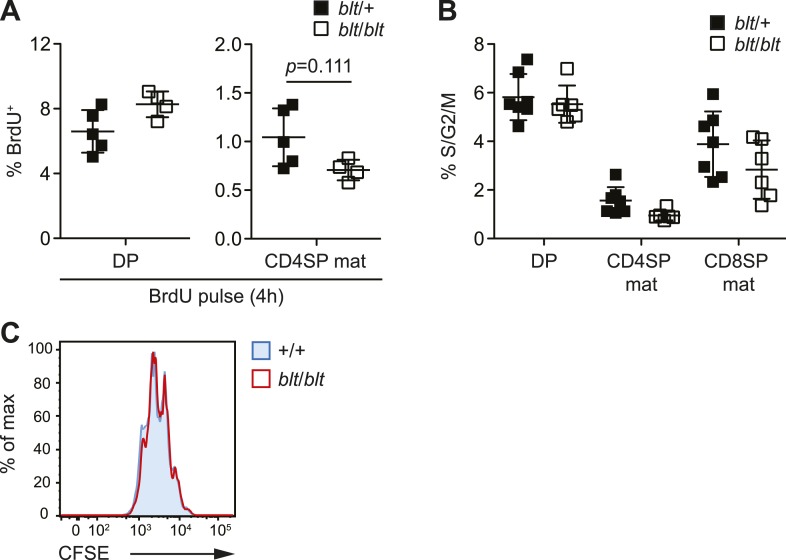
blt/blt naïve T cells proliferate normally in response to TCR
stimulation in vitro and show no significant reduction in cycling of
mature SP thymocytes.(A) BrdU labeling of DP and mature CD4SP thymocytes from
blt/+ (n = 5) and
blt/blt (n = 4)
mice after a 4 h pulse (mean ± s.d., two-tailed Mann-Whitney test).
(B) Percentage of indicated thymocyte subsets in S/G2/M
phases of the cell cycle, as defined by >2n DNA content. Data pooled
from three independent experiments (mean ± s.d., n =
6–7). (C) Analysis of CFSE dilution by congenically marked
WT and blt/blt CD4+ naïve T cells in mixed
culture, after 3 days of stimulation with plate-bound αCD3 and αCD28.
Data are representative of two independent experiments.